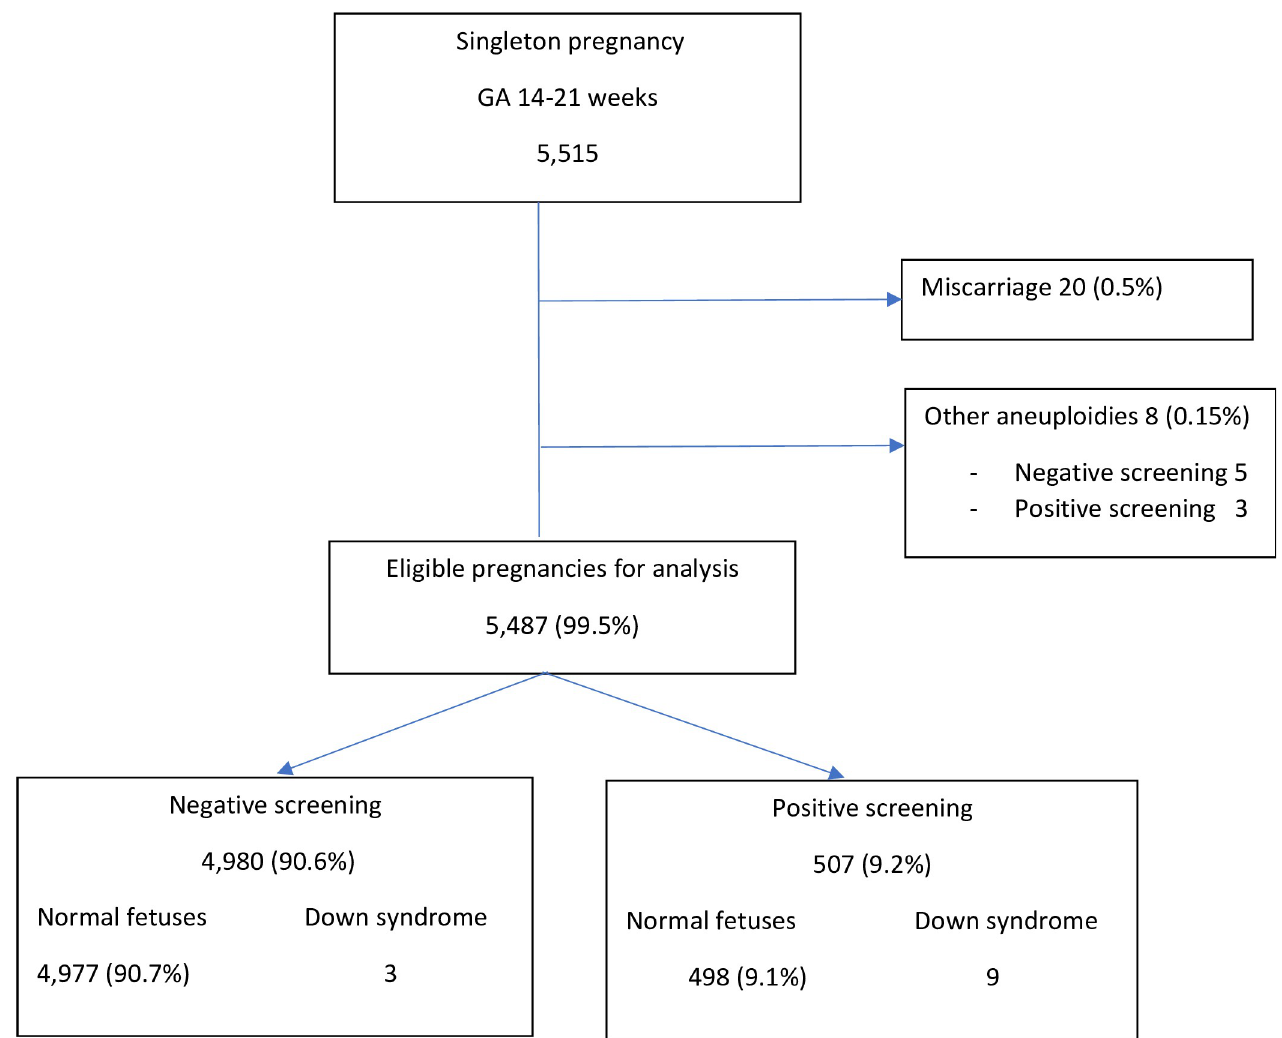
Fig 1. Flow chart of the pregnant women who underwent quadruple serum screening for Down syndrome.